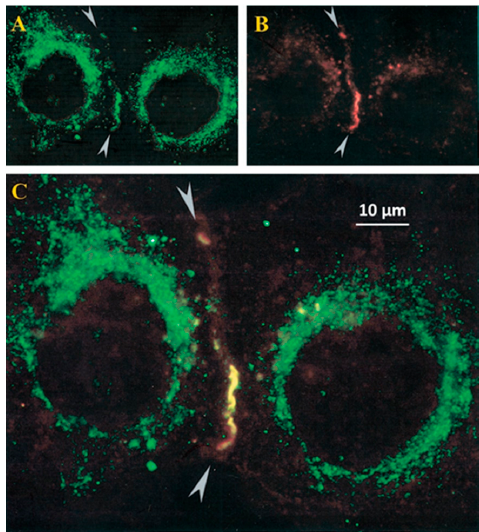
Figure 4. Immunofluorescence labeling of CaM ( A ) and Cx32 ( B ) in HeLa cells expressing Cx32. CaM and Cx32 colocalize in linear (regions between arrowheads) and punctated areas of cell–cell contact ( C ). Labeling is also seen in the cytoplasm ( A – C ); this is likely to correspond to CaM and CaM linked to Cx32 in cytoplasmic organelles. Scale bar 10 µm. From [39].